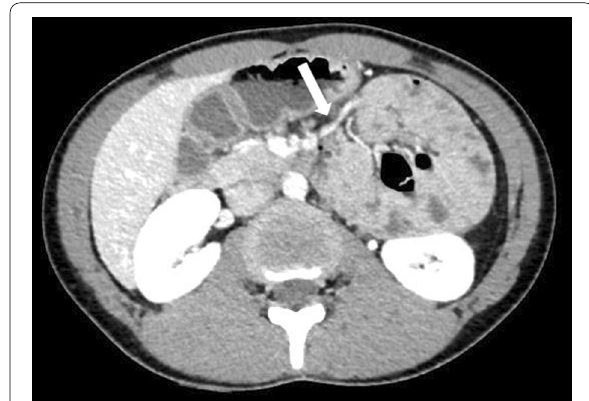
Fig. 1 A multi-detector contrast-enhanced computed tomography scan showed no signs of ischemic findings. The small bowel was congregated on the left upper quadrant of the abdomen through the dorsal side of the inferior mesenteric vein (white arrow)